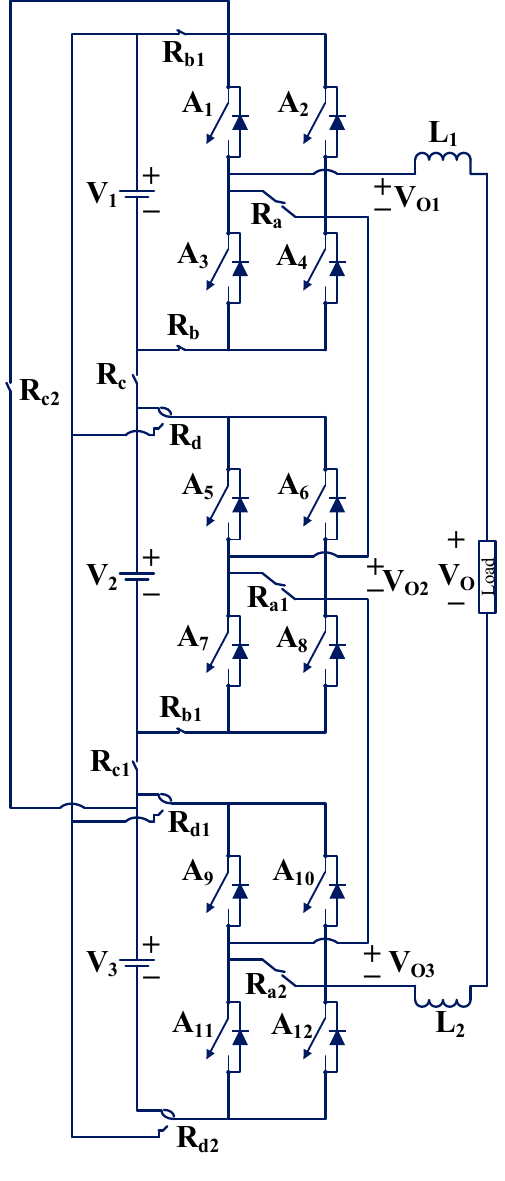
Figure 45. Single-phase seven-level FT MLI (TP49)